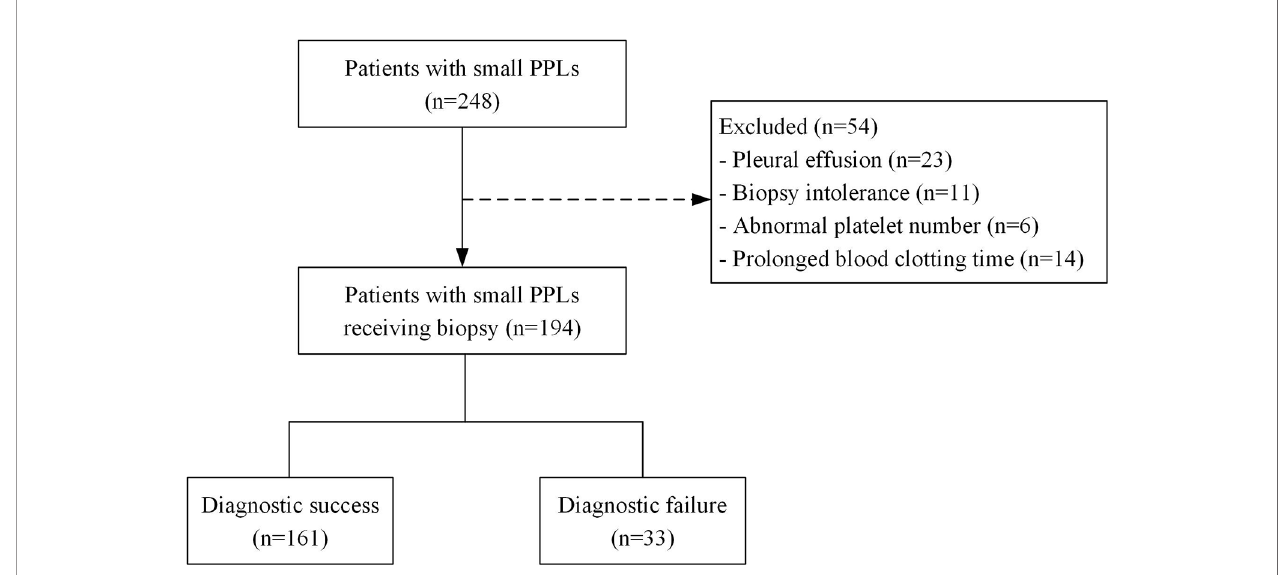
FIGURE 1 | Flow chart of patient inclusion. PPLs, peripheral pulmonary